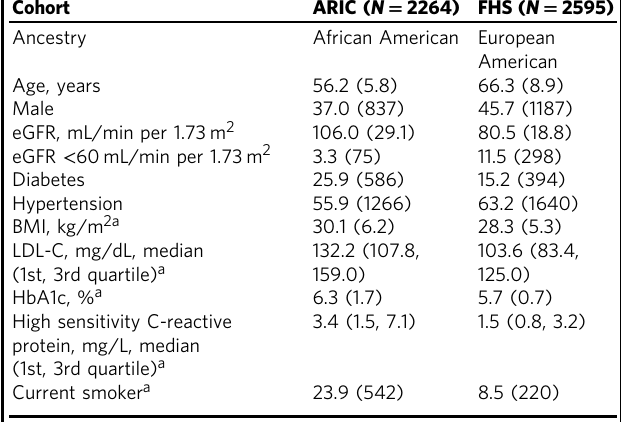
Table 1 Baseline clinical characteristics of the Atherosclerosis Risk in Communities Study (ARIC) and the Framingham Heart Study (FHS). Continuous variables